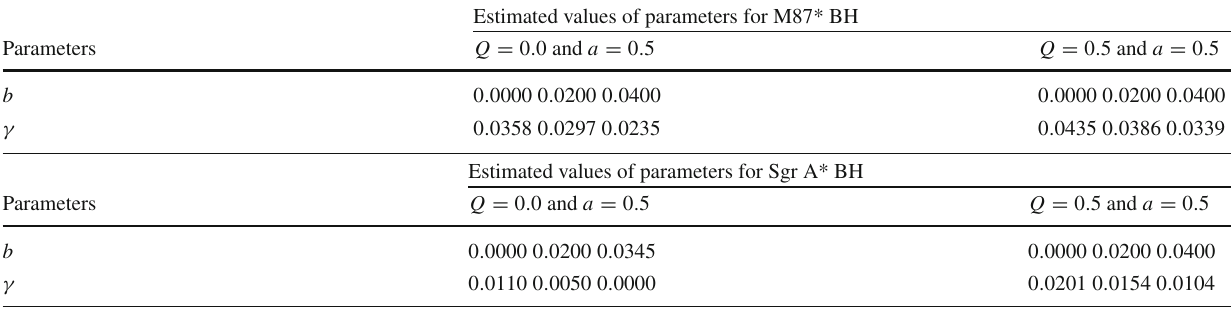
Table 1 The upper values of γ and a are tabulated for the supermassive BHs in the galaxy M87* and the Sgr A*. Note that we set M =